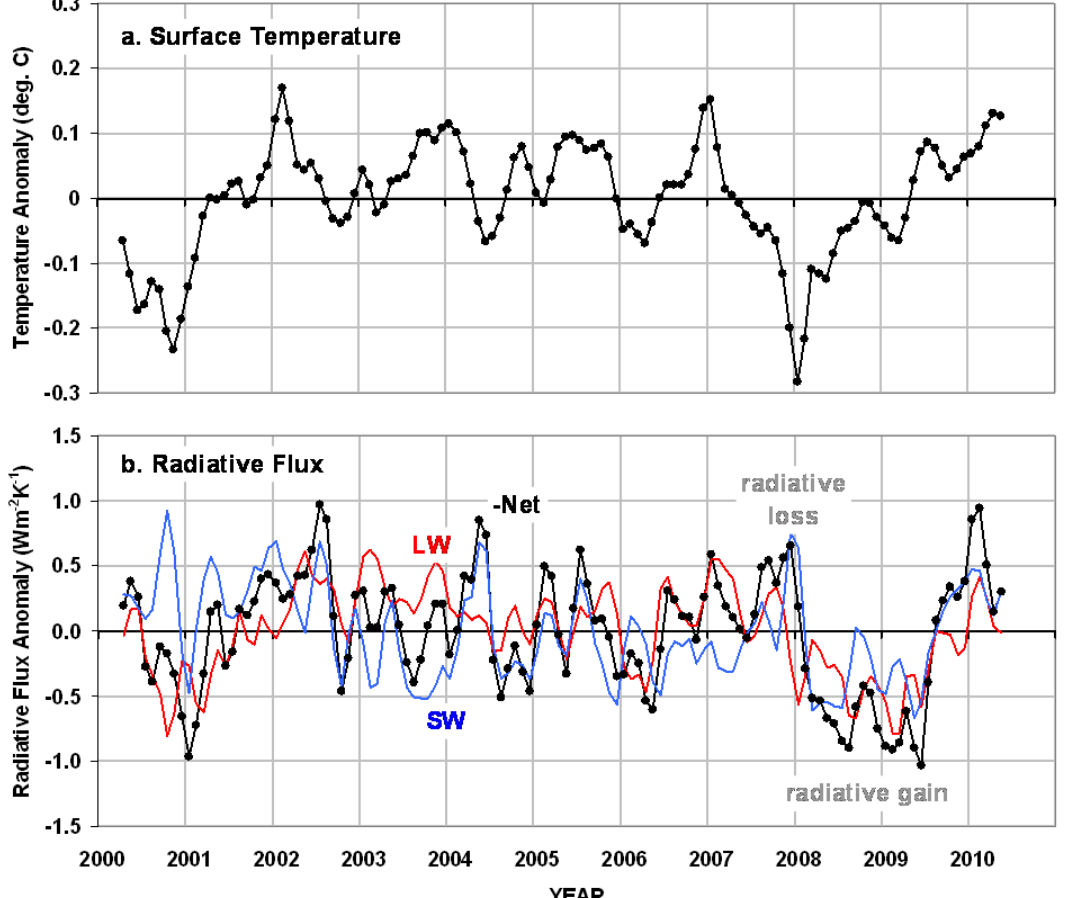
Figure 2. Times series of monthly global average anomalies in (a) surface temperatures from HadCRUT3, and (b) radiative fluxes from Terra CERES SSF Edition 2.5, for the period March 2000 through June 2010. All time series have a 1-2-1 smoother applied to reduce sampling